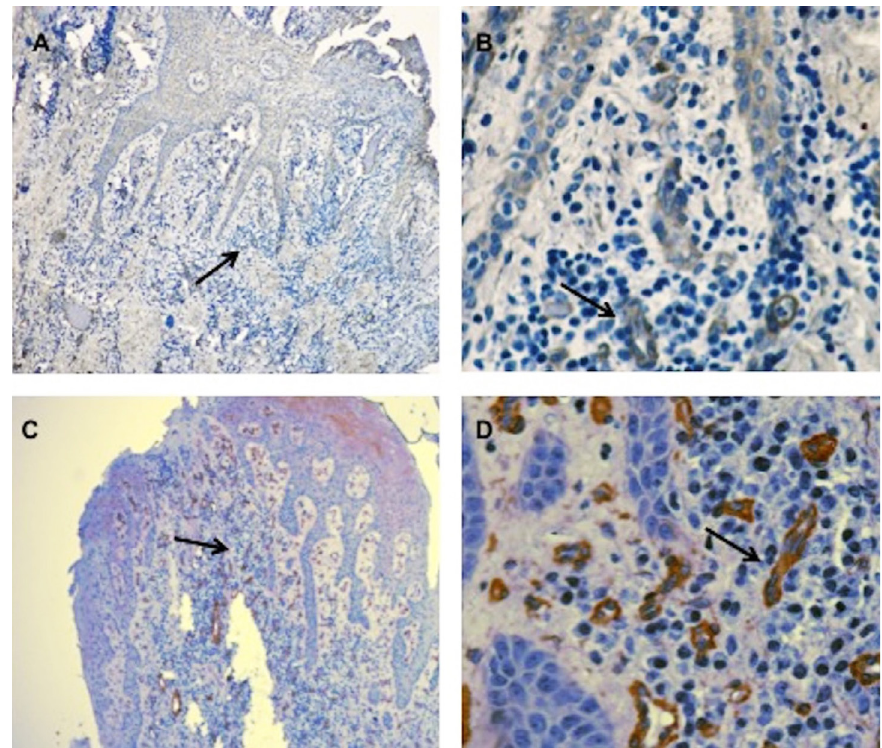
Figure 2- Cellular localization of IFN- g R2 on gingival tissues in chronic periodontitis patients (CP) and healthy subjects (HS) by immunohistochemistry. Surface expression of IFN- g R2 in endothelial cells of healthy subjects (A, B); and surface expression of IFN- g R2 in endothelial cells of CP patients (C, D); we must highlight that IFN- g R2 is strongly expressed in the endothelial cells of CP patients (B) when compared to HS (D), as well as an increase in the vasculature in the gingival tissue of CP patients (C and D) when compared to HS (A and B). (A and C, original magnification x10); (B and D, original magnification x60). Hematoxylin counterstained